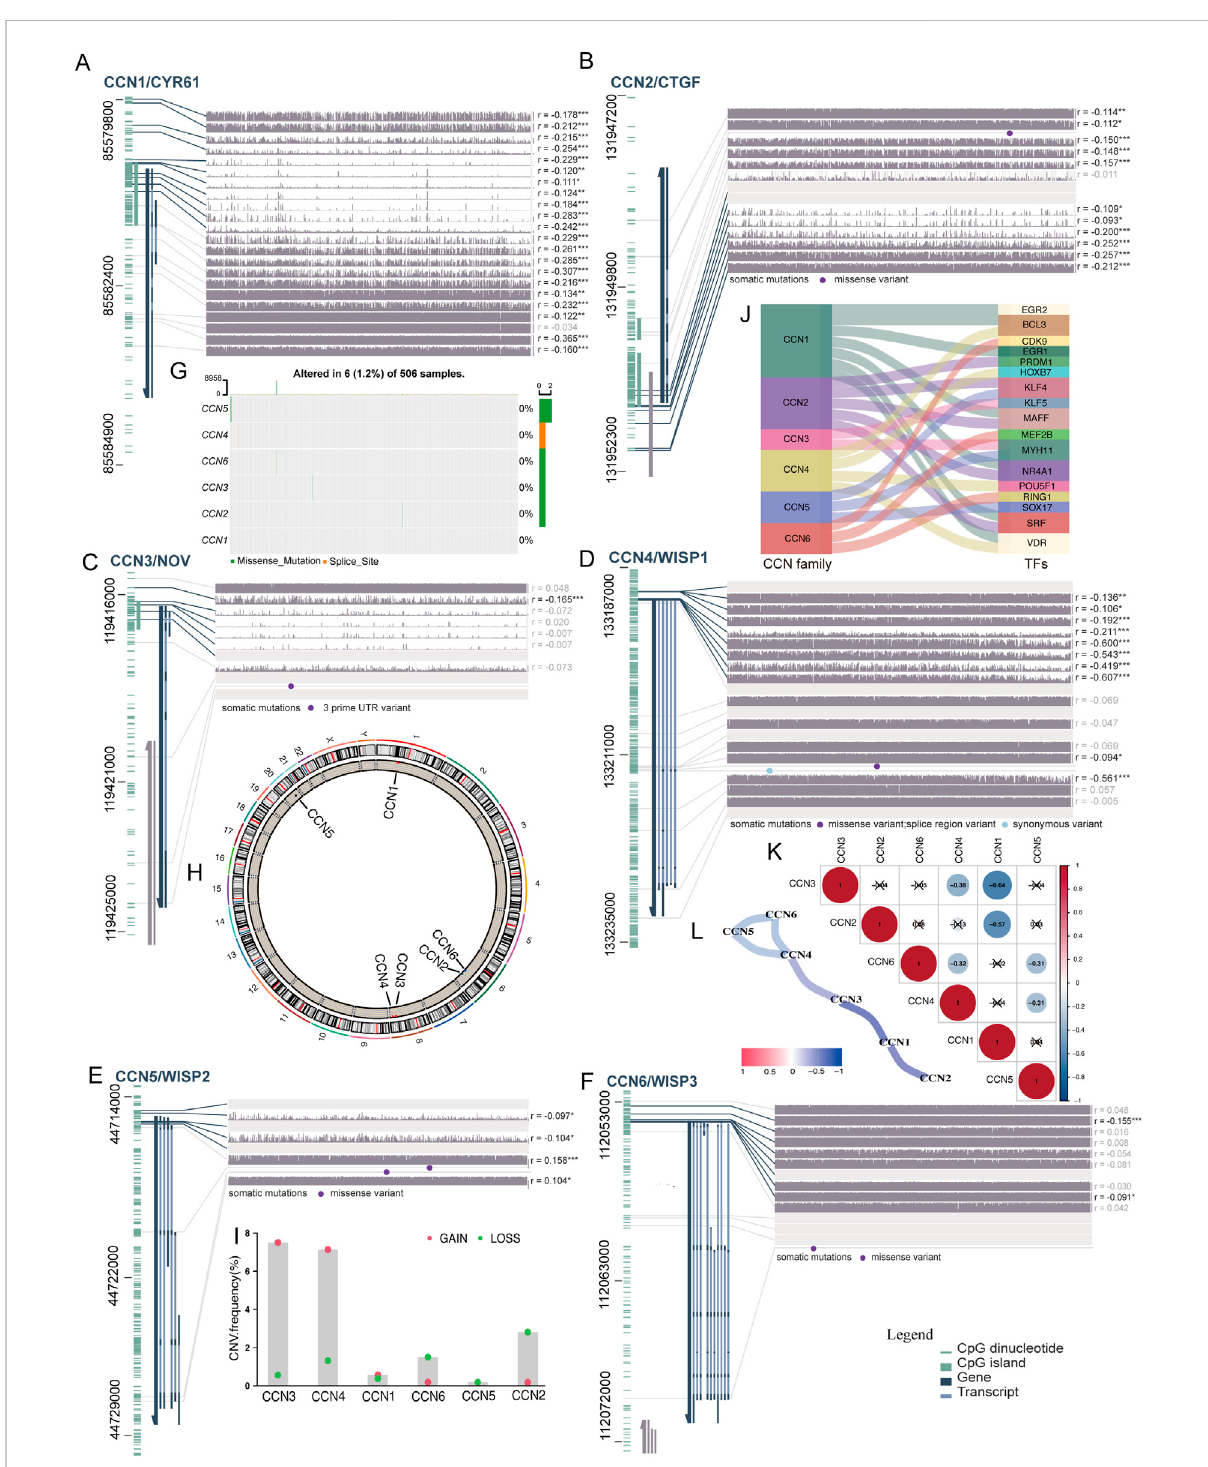
FIGURE 7 A landscape of multi-omics changes of the CCN family in LGG. (A – F) Overview of methylation, transcripts and mutations of the CCN family in the TCGA-LGG cohort. Each row shows the DNA methylation data for a single probe on the In fi nium microarray, the darkened line indicates promoter methylation. The gene together with its transcripts, as well as any CpG islands and all the individual CpG dinucleotides are shown on the left, and the r value indicates the correlation between gene methylation and expression. r: Pearson correlation coef fi cient. (G) Waterfall plot showing CCN family mutations in 506 LGG patients from the TCGA-LGG cohort. The upper bar graph shows the tumor mutation burden for each patient. The number on the right indicates the mutation frequency of the CCNs gene, and the bar on the right shows the patient number for